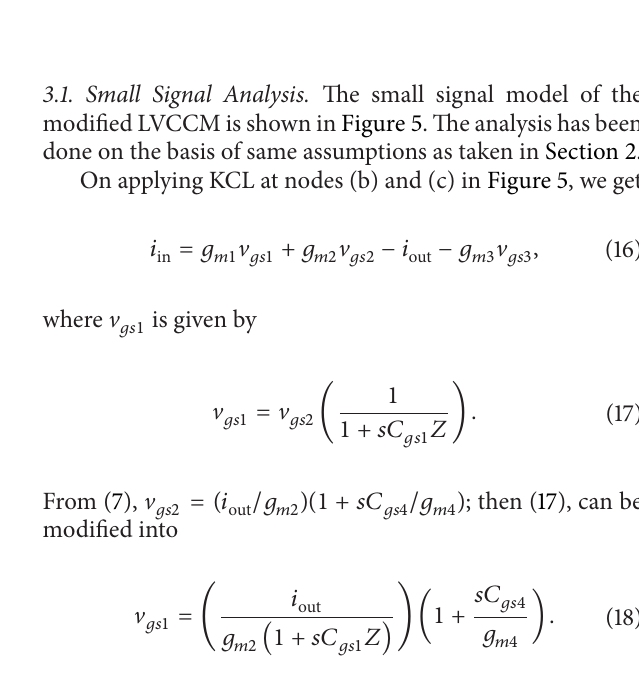
Figure 5: Small signal model of the compensated